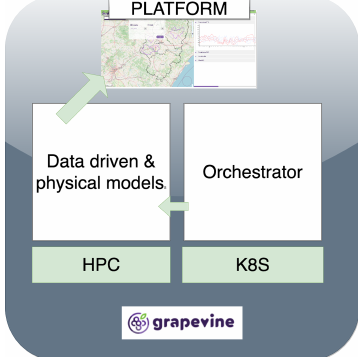
Figure 1. Grapevine high-level